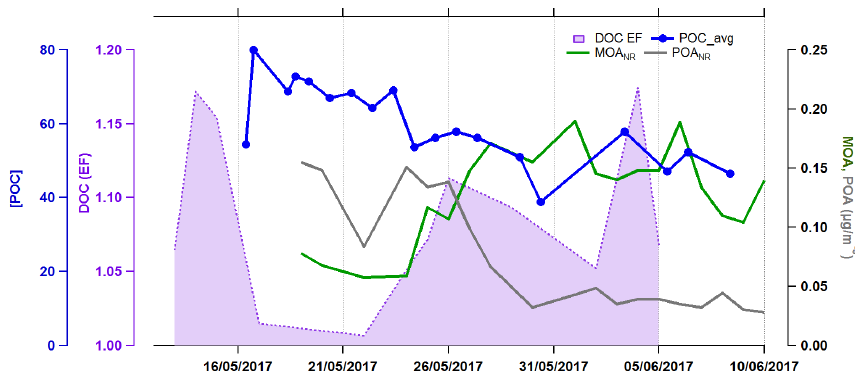
Figure 7. Time series of the DOC enrichment factor (EF), POC concentrations, and PMF organic factors MOA NR and POA NR